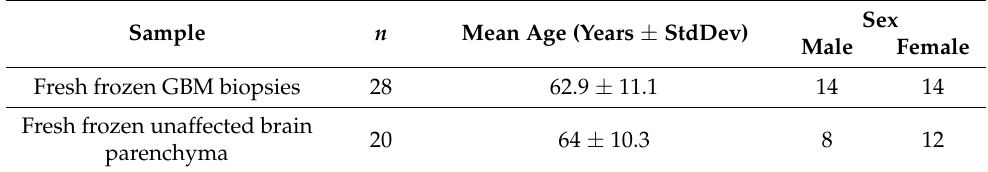
Table 3. Demographic data including sex and age of the study